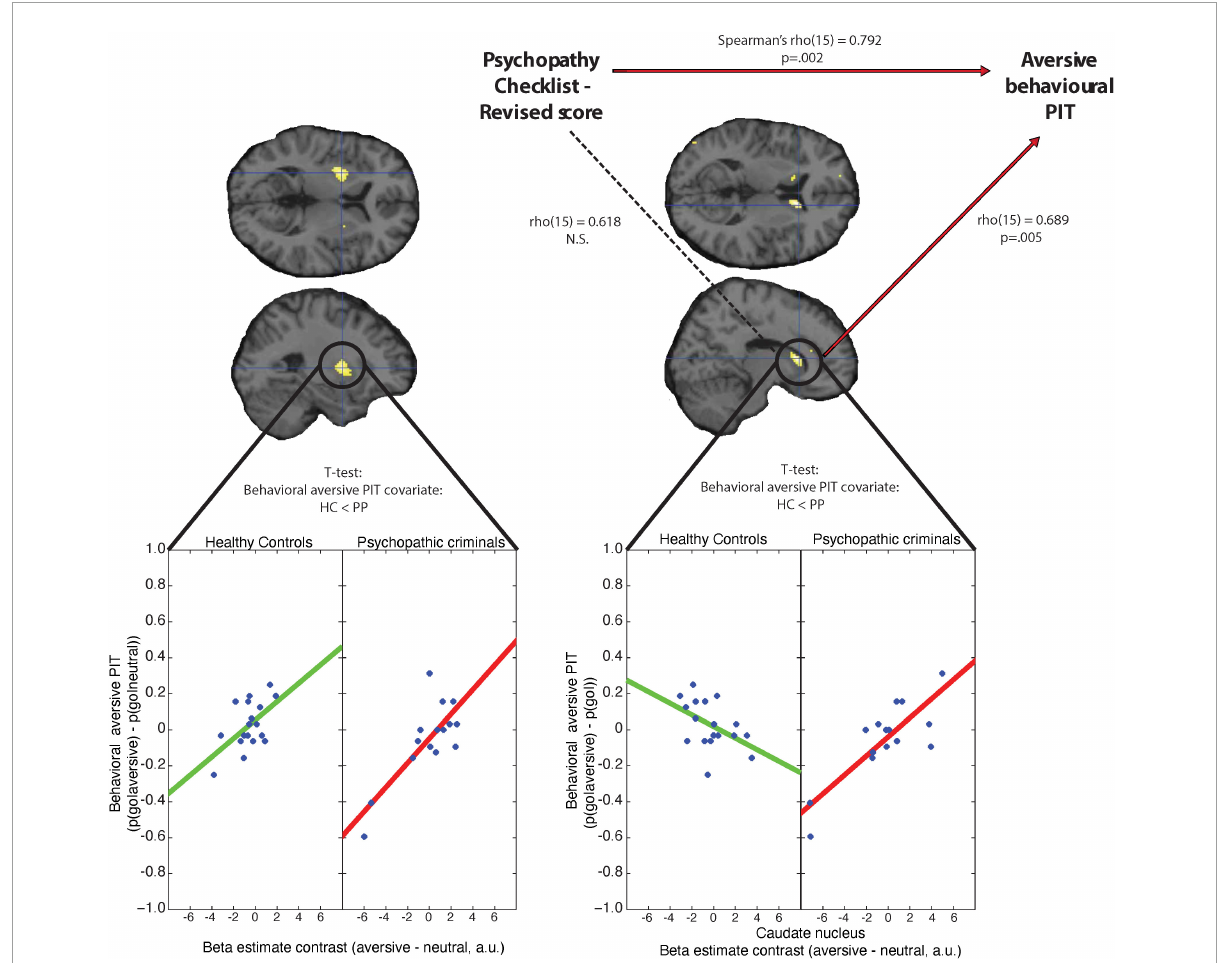
FIGURE3 Association between aversive behavioral PIT, beta estimate contrasts (neutral–aversive trials) and psychopathy severity (in terms of the psychopathy checklist–revised total score) for the putamen and the caudate nucleus. Left panel: Beta estimate contrasts (neutral–aversive trials) within the putamen are positively correlated with behavioral aversive PIT [ p (go| neutral)– p (go| aversive)] for violent offenders and healthy controls. Right panel: Beta estimate contrasts (neutral–aversive trials) within the caudate nucleus correlate positively with behavioral aversive PIT [ p (go| neutral)– p (go| aversive)] for psychopathic criminals, but not for healthy controls. Correlations between the mean beta estimate contrasts and PCL-R and aversive behavioral PIT are calculated in terms of Spearman’s rho. Scatterplots are for illustrative purposes only and were created by plotting the behavioral PIT effect against the extracted average beta estimate contrast from the p < 0.001 whole-brain uncorrected clusters within the putamen and caudate